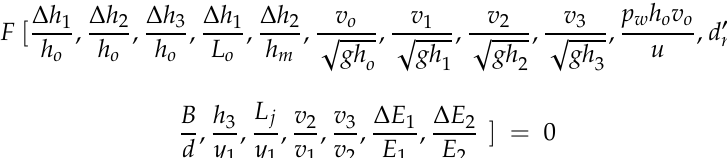
Figure 3. Schematic diagram of experimental model.